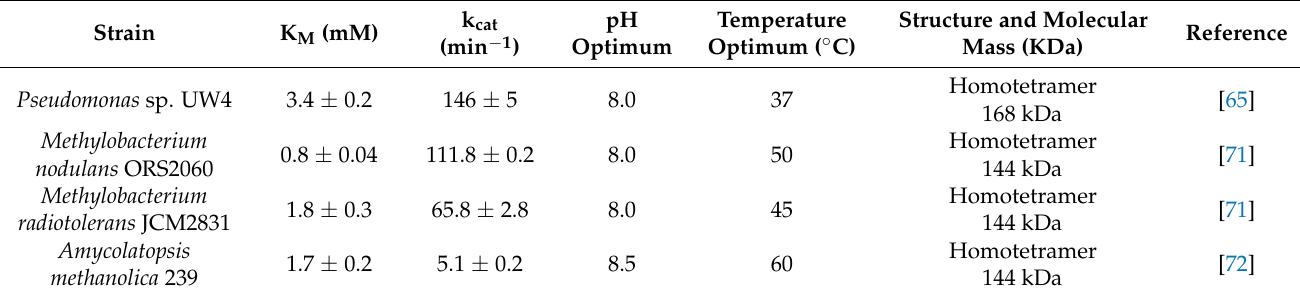
Table 2. Properties of the Pseudomonas sp. UW4 and other studied bacterial ACC deaminase enzymes.